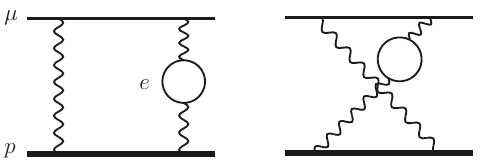
Figure 3 . Contribution to δc pµ 4 due to electron vacuum polarization